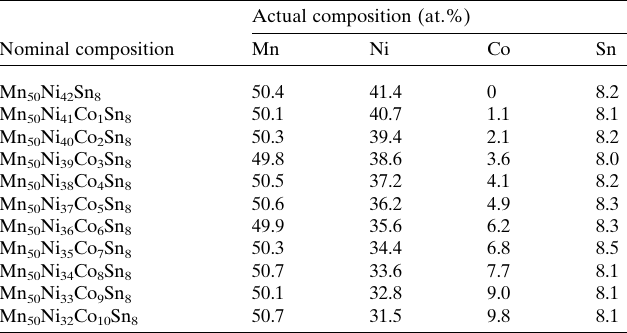
Table 1 EDS results for Mn 50 Ni 42 (cid:2) x Co x Sn 8 ( x = 0–10) melt-spun ribbons. Actual composition (at.%)